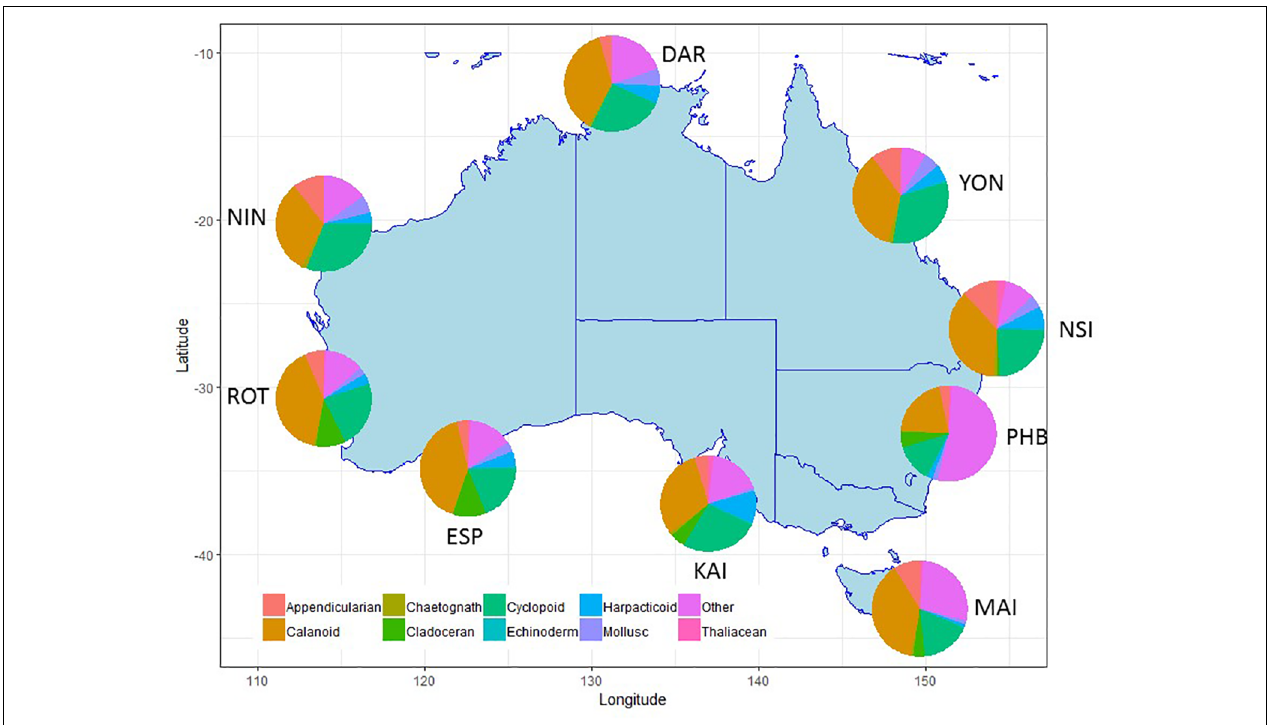
FIGURE 6 | Major taxonomic or functional groups zooplankton taxa counted in the NRS survey, all samples combined. Site details and codes are as per Table 1